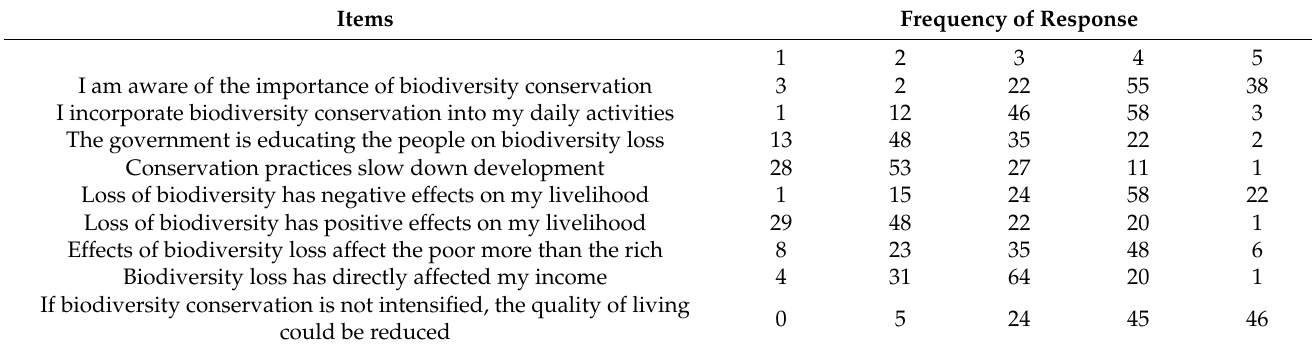
Table 3. Frequencies of responses on 9 Likert Scale